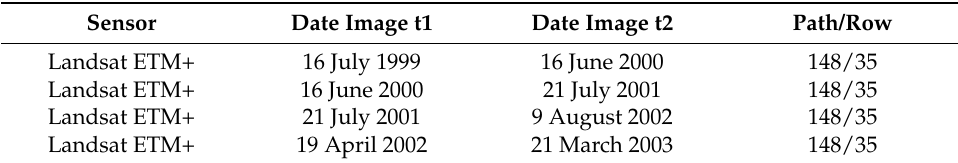
Table 1. Landsat ETM+ image pairs used in this